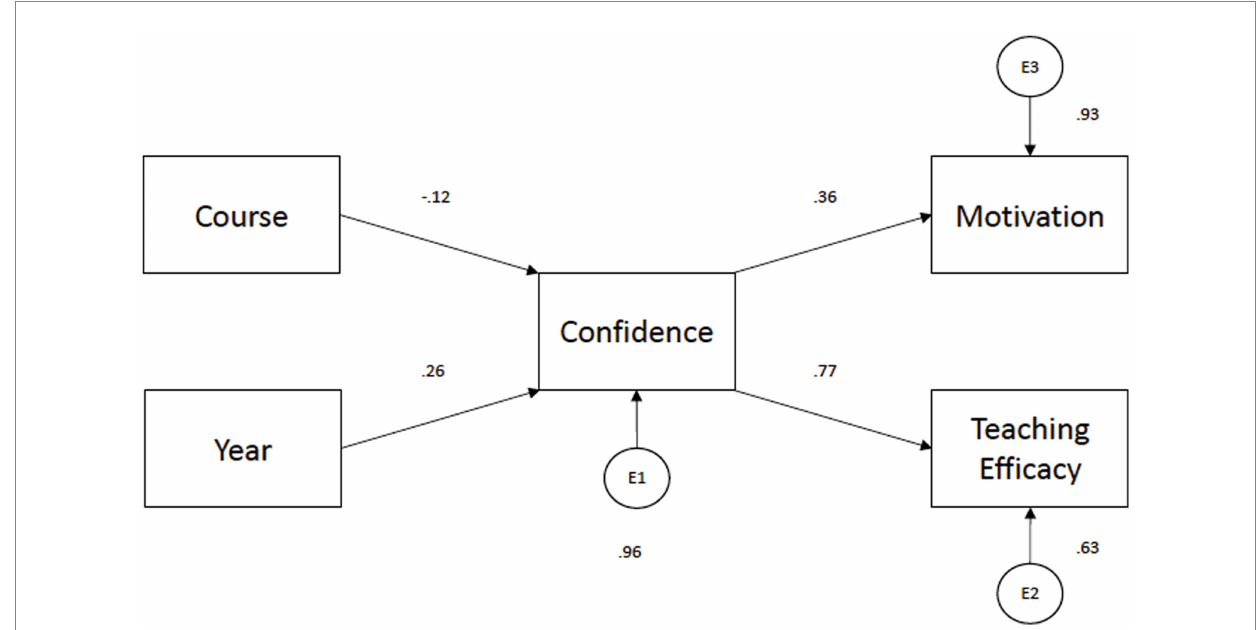
FIGURE 2 Path model of relationships between confidence, motivation and teaching